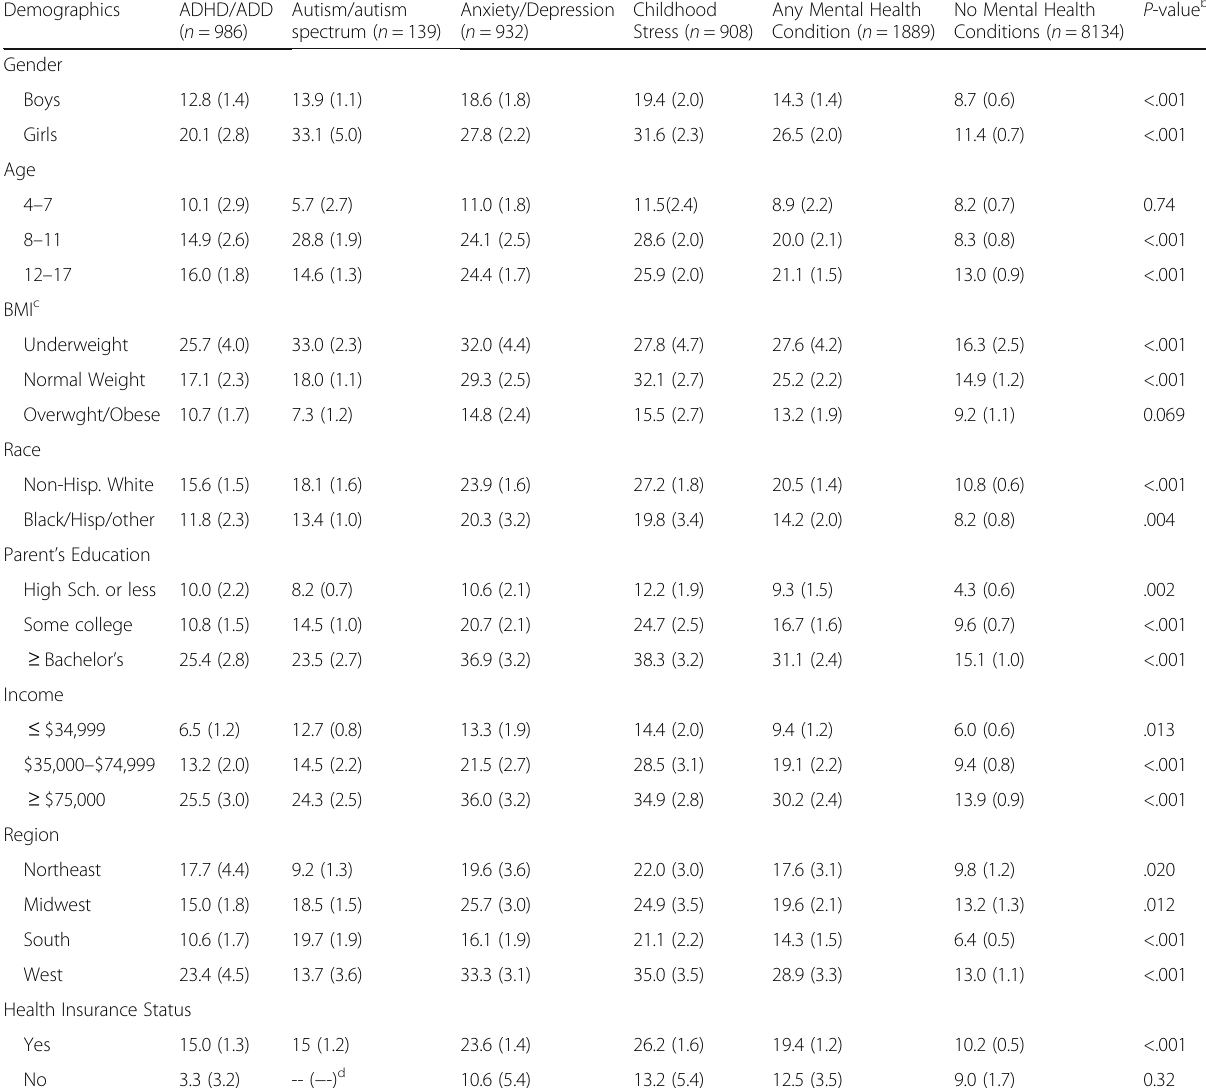
Table 3 Percent CAM use a (standard error) by demographics among children with mental health conditions and without any mental health condition during the past 12 months